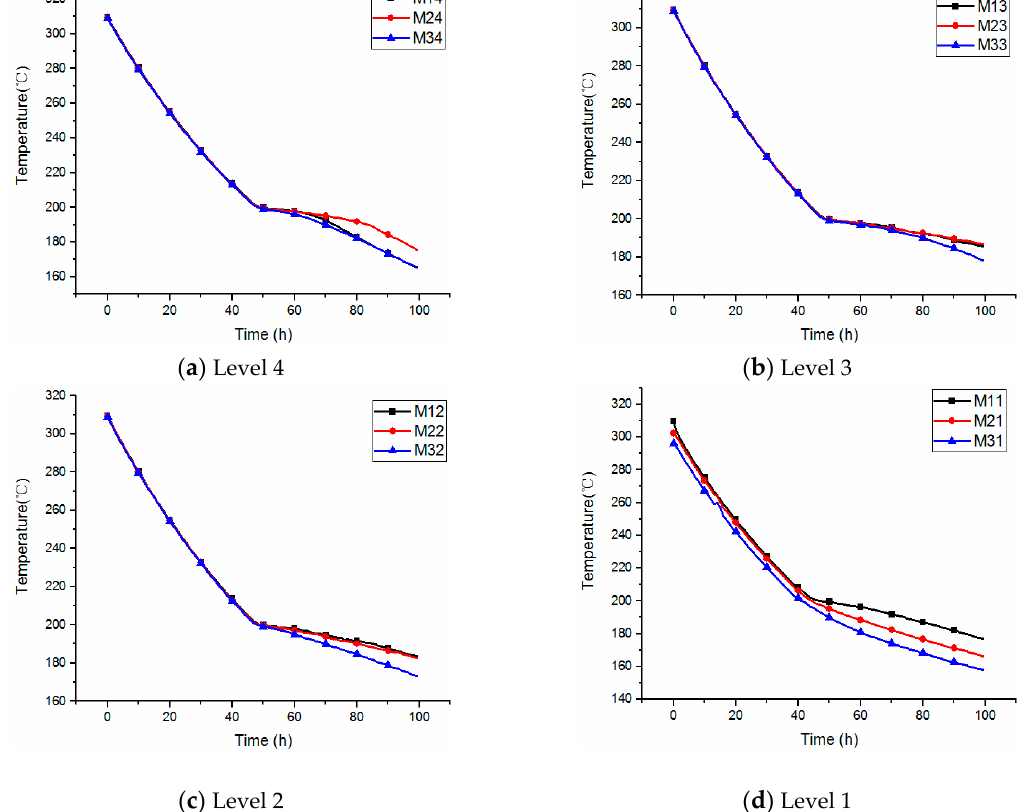
Figure 9. Temperature distribution of molten salt at 300~180 °C at various levels.